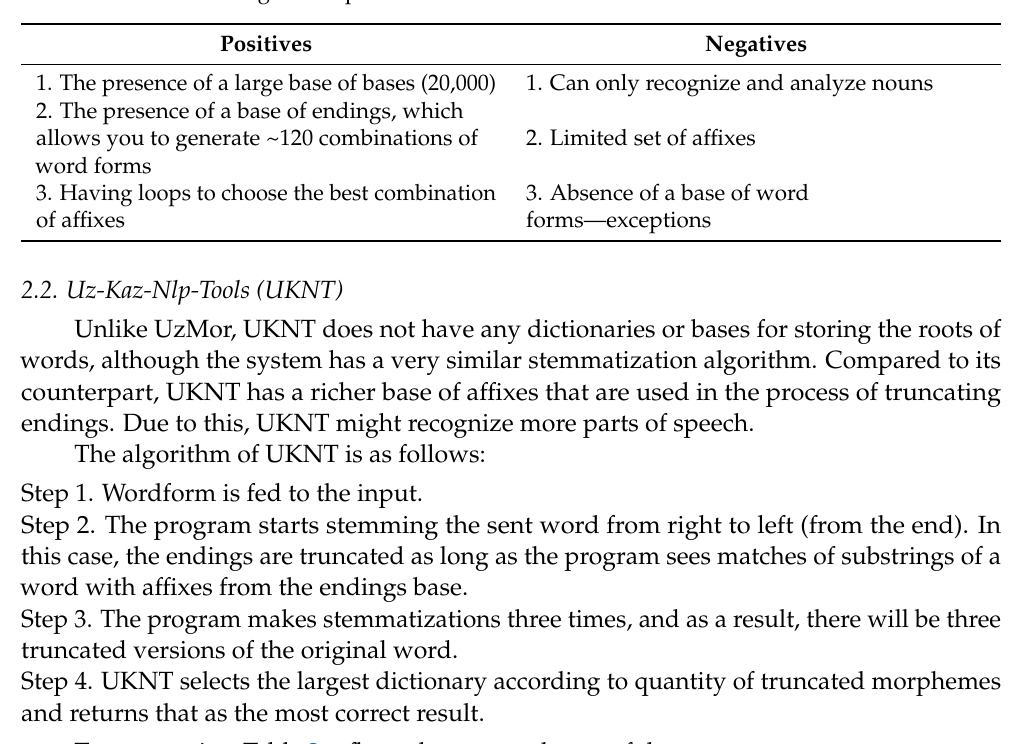
Table 1. Positive and negative aspects of